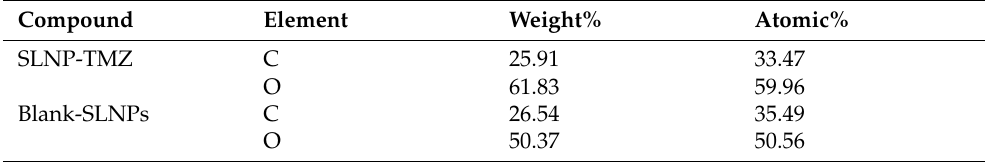
Table 3. Elemental composition of SLNPs through Energy Dispersive Spectroscopy (EDS).